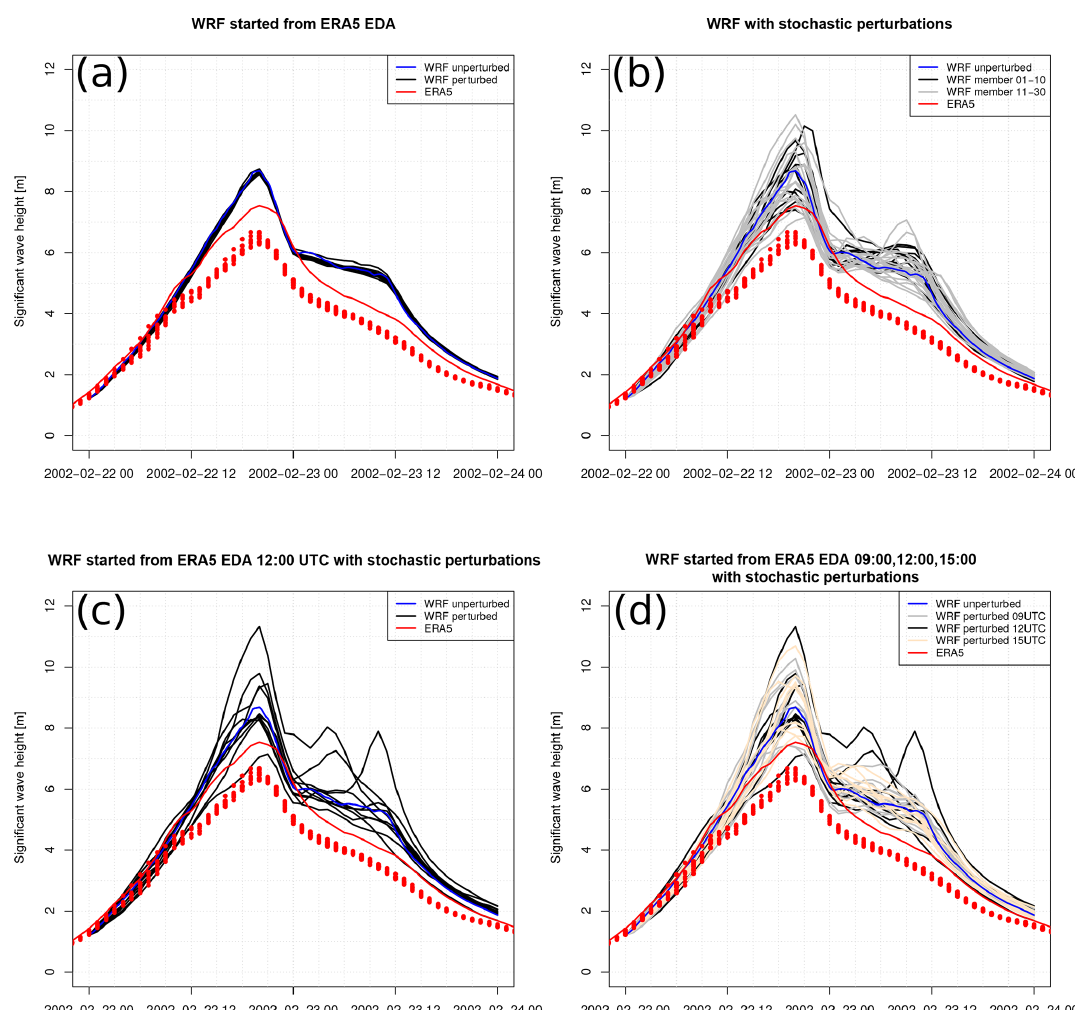
Figure 6. Significant wave height (m) at station Northern Baltic (59.25 ◦ N, 21.00 ◦ E; see Fig. 1), driven by the WRF ensemble based on (a) initializations at 21 February 2002 12:00UTC from ERA5 EDA, (b) ERA5 reanalysis and stochastic perturbations, (c) ERA5 EDA with SKEB and SPPT, and (d) ERA5 EDA with SKEB and SPPT initialized additionally on same day at 09:00 and 15:00UTC; ERA5 significant wave heights from the ECWAM model in 0.36 ◦ resolution; Shown are results for 22 February 2002